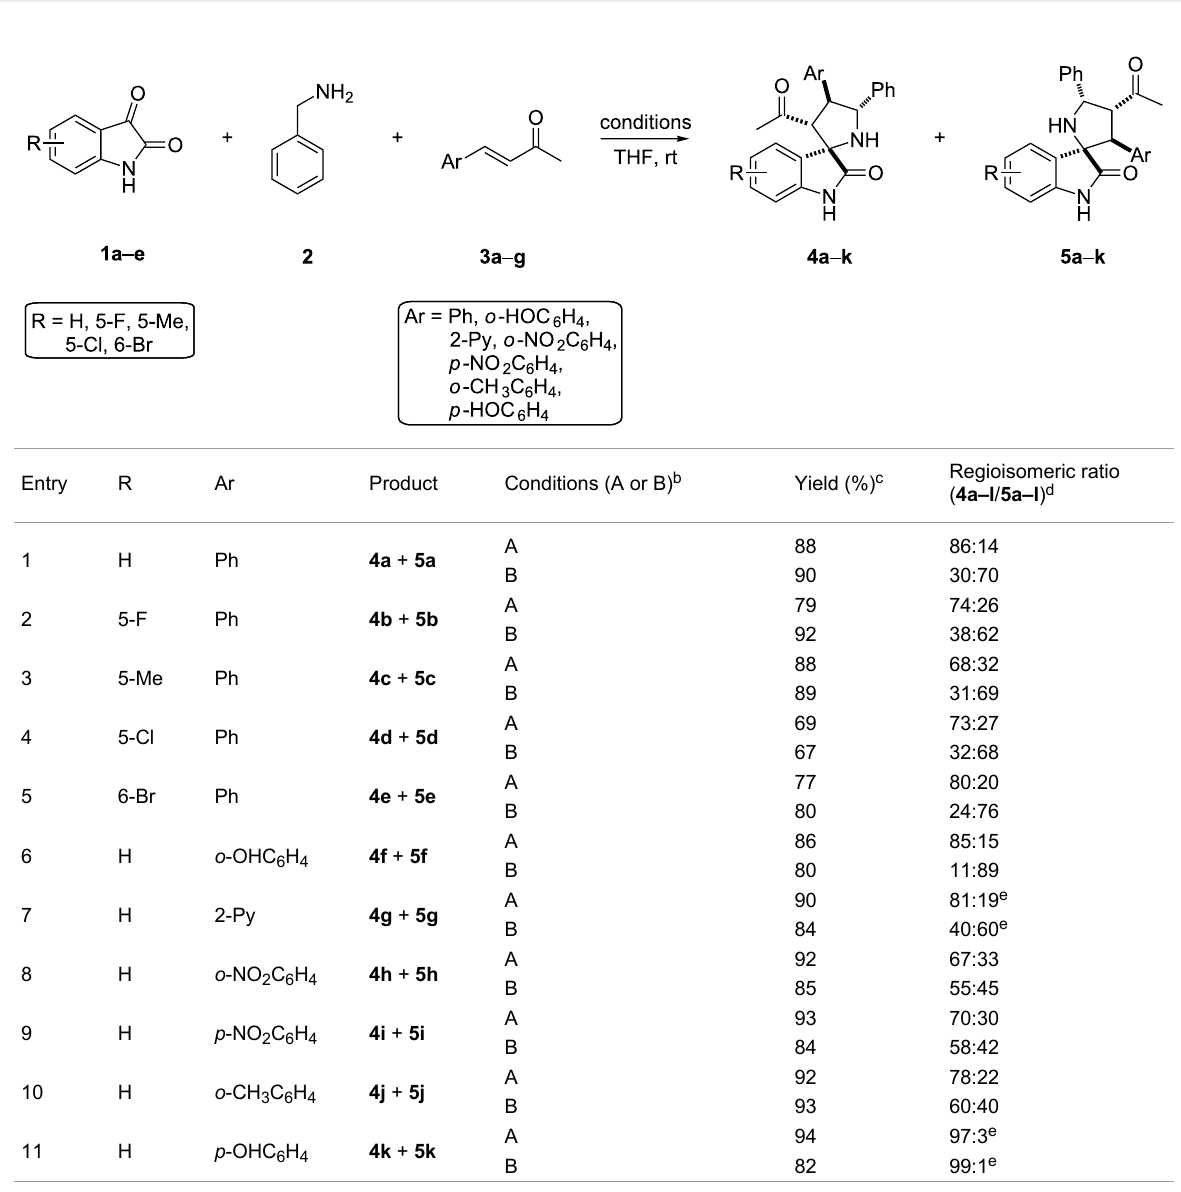
Table 3: 1,3-Dipolar cycloaddition reaction of isatin derivatives 1a–e and benzylamine ( 2 ) with benzylideneacetone derivatives 3a–g a